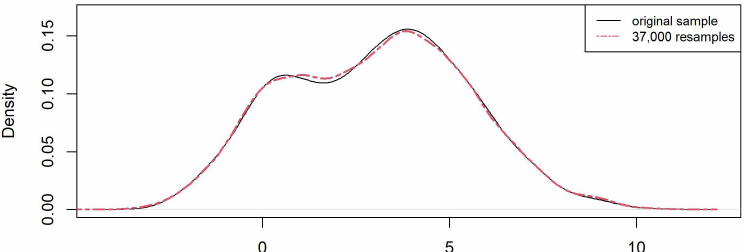
Figure 2. The plots of the smoothed density functions given by { x i } (solid line) for i = 1, . . . ,1000 and a set of resampled values { ˜ x i } determined by D M < 0.007 (dash line).